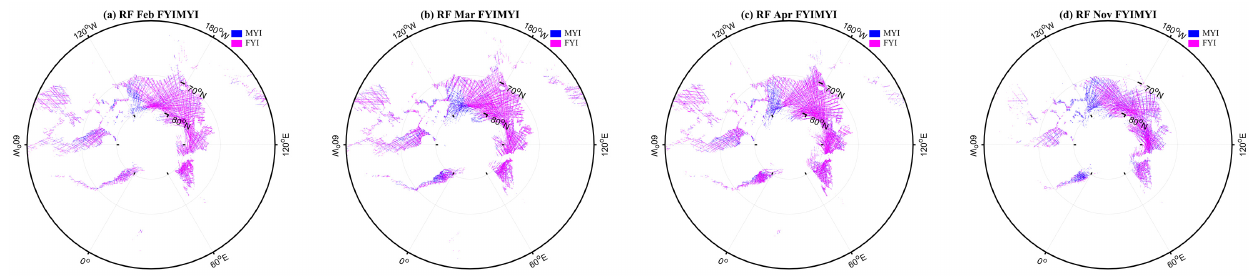
Figure A14. RF for FYI-MYI classification using the data in November as the training set. The data in ( a ) February, ( b ) March, ( c ) April, and ( d ) December are used as the test set in turn.